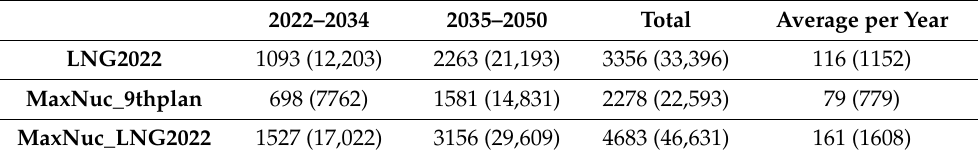
Table 3. Summary of avoided premature mortality (and YLL) compared to